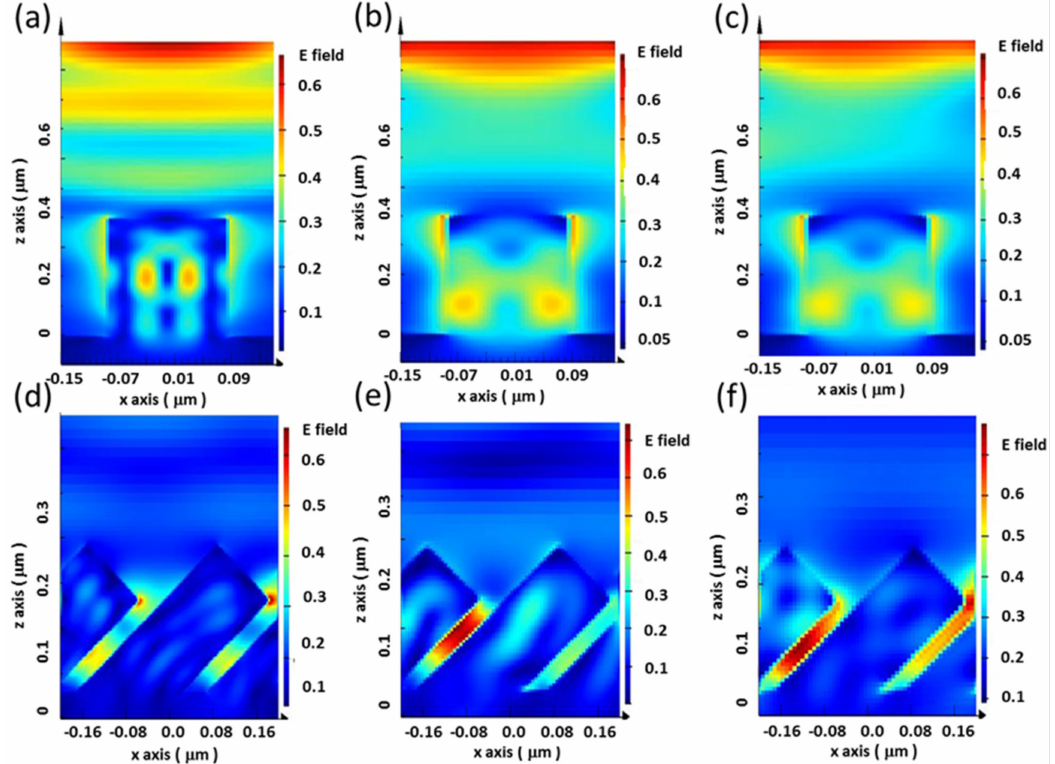
Figure 6. Examinations of illuminated electric field of samples under various incident angles of lights, where the angle was defined relative to the substrate plane: ( a ) 90 ◦ , ( b ) 60 ◦ , and ( c ) 45 ◦ as the angle of light irradiance on vertical SiNWs. ( d ) 90 ◦ , ( e ) 60 ◦ , and ( f ) 45 ◦ as the angle of light irradiance on inclined